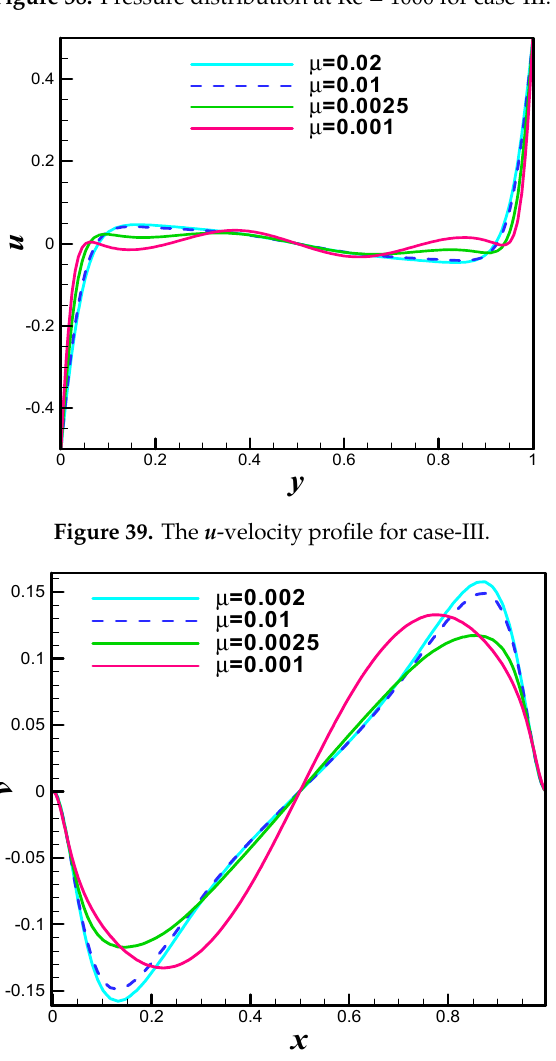
Figure 40. The v - velocity profile for case-III.